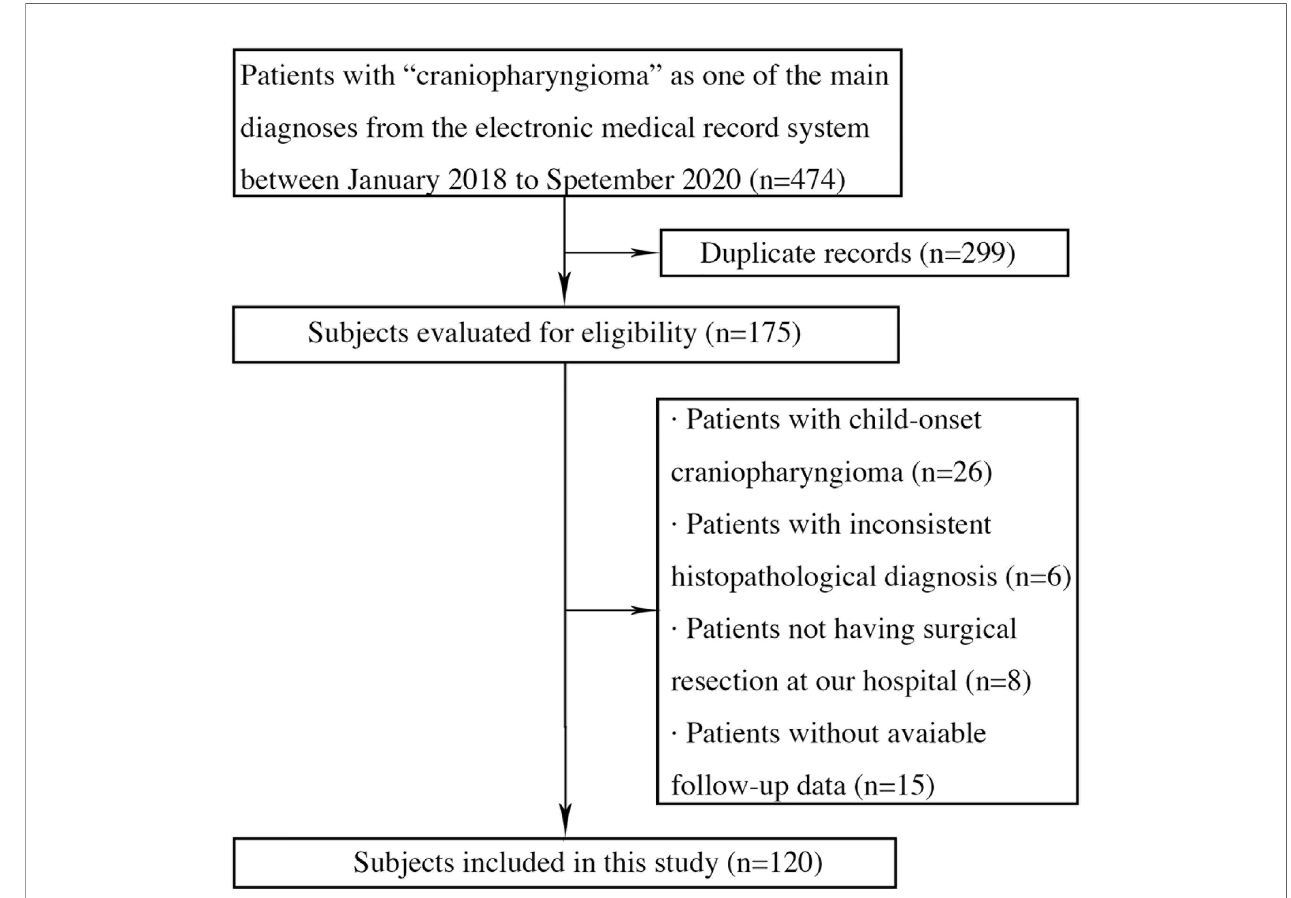
FIGURE 1 | Flow chart of subjects included in this